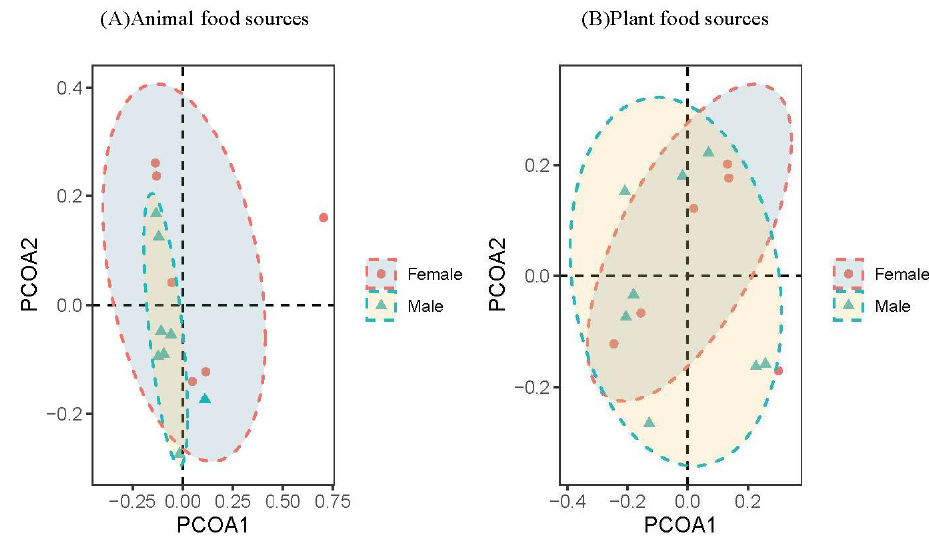
Figure 4. PCOA analysis for male and female wild boars.